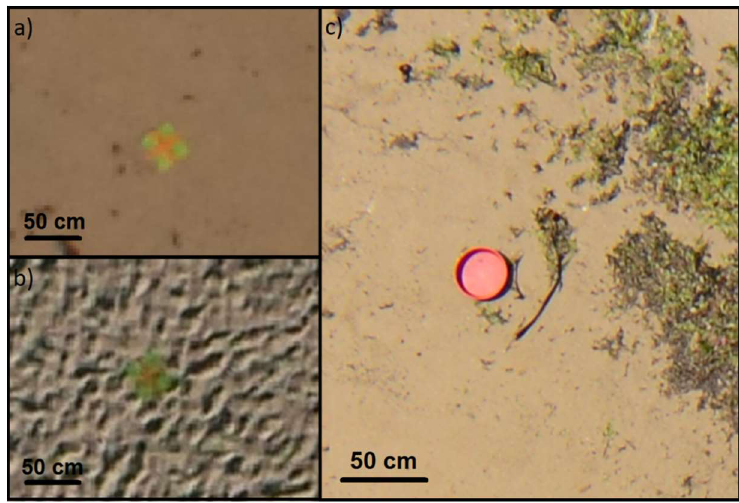
Figure 5. Examples of the different types of targets used as ground control points (GCPs): ( a , b ) light green and orange square plastic targets with varying illumination conditions (photos respectively taken in 2006 and 2008); ( c ) 30 cm red plastic plate currently used (photo taken in 2015).